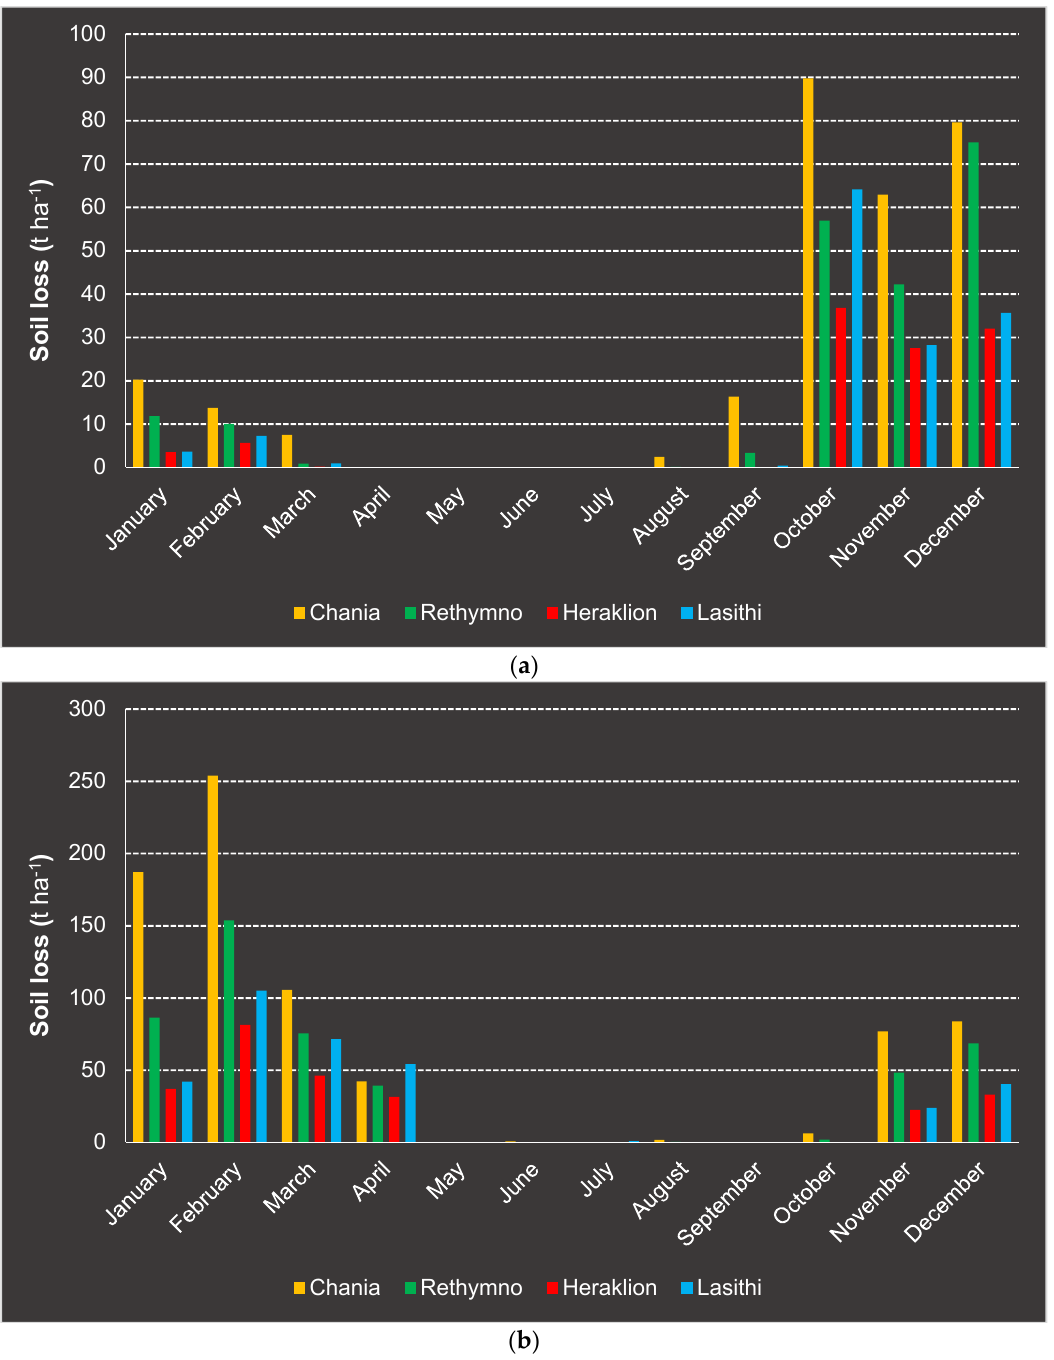
Figure 9. Monthly variation of mean soil loss rate per administrative prefecture of Crete Island: ( a ) in 2016; ( b ) in 2019.